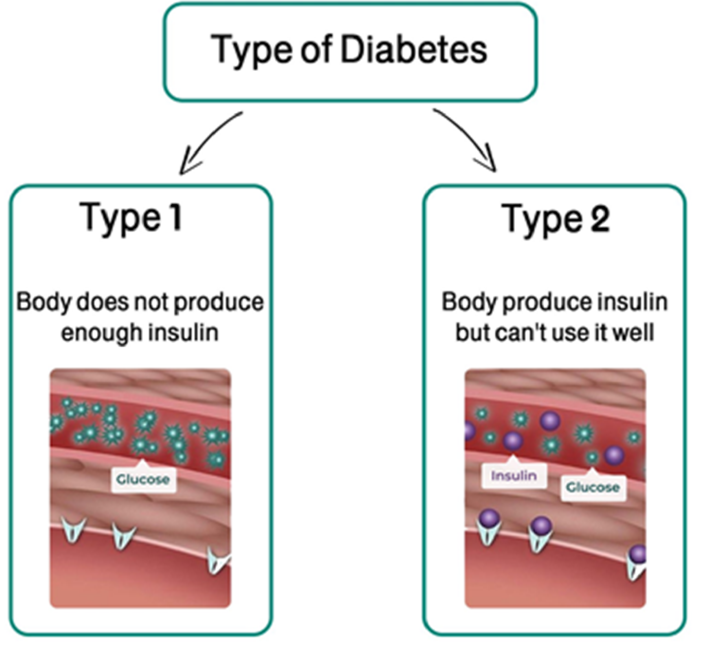
Figure 1. The types of